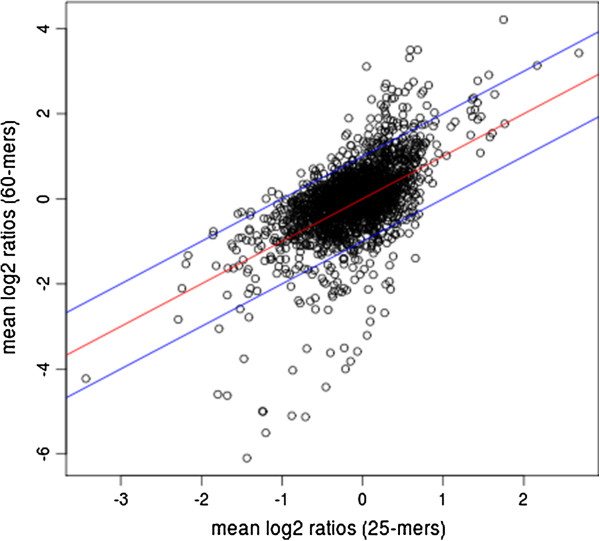
The inter-array type’s correlation of expression profiles. Scatter plot was realized using means of log2 ratio of probe intensities in all replicates and shows a strong correlation between the two array types.